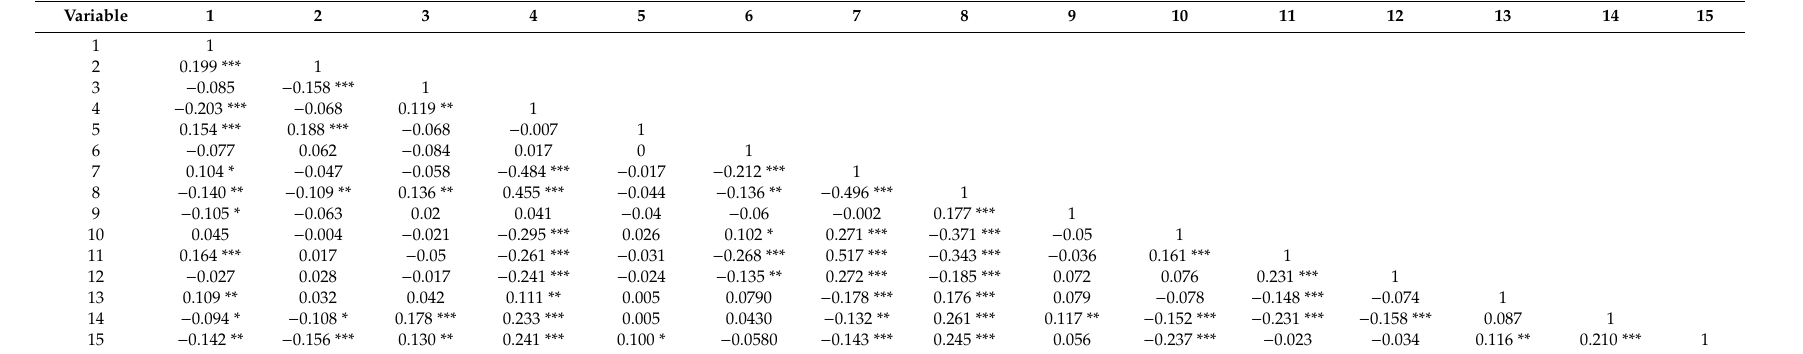
Table 3. Correlation coe ffi cient matrix of model